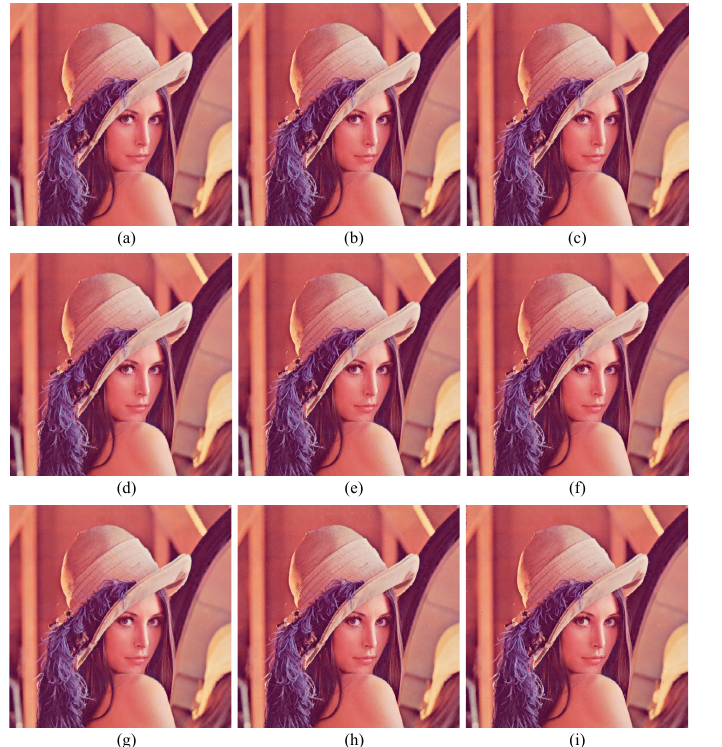
Figure 9. Comparisons of Lena image by three methods; ( a ) CAMBTC, EC = 50,000, ( b ) PRO- POSE#1, EC = 50,000, ( c ) PROPOSED#2, EC = 50,000, ( d ) CAMBTC, EC = 250,000, ( e ) PRO- POSE#1, EC = 250,000, ( f ) PROPOSE#2, EC = 250,000, ( g ) CAMBTC, EC = 375,000, ( h ) PROPOSE#1, EC = 375,000, and ( i ) PROPOSE#2, EC =